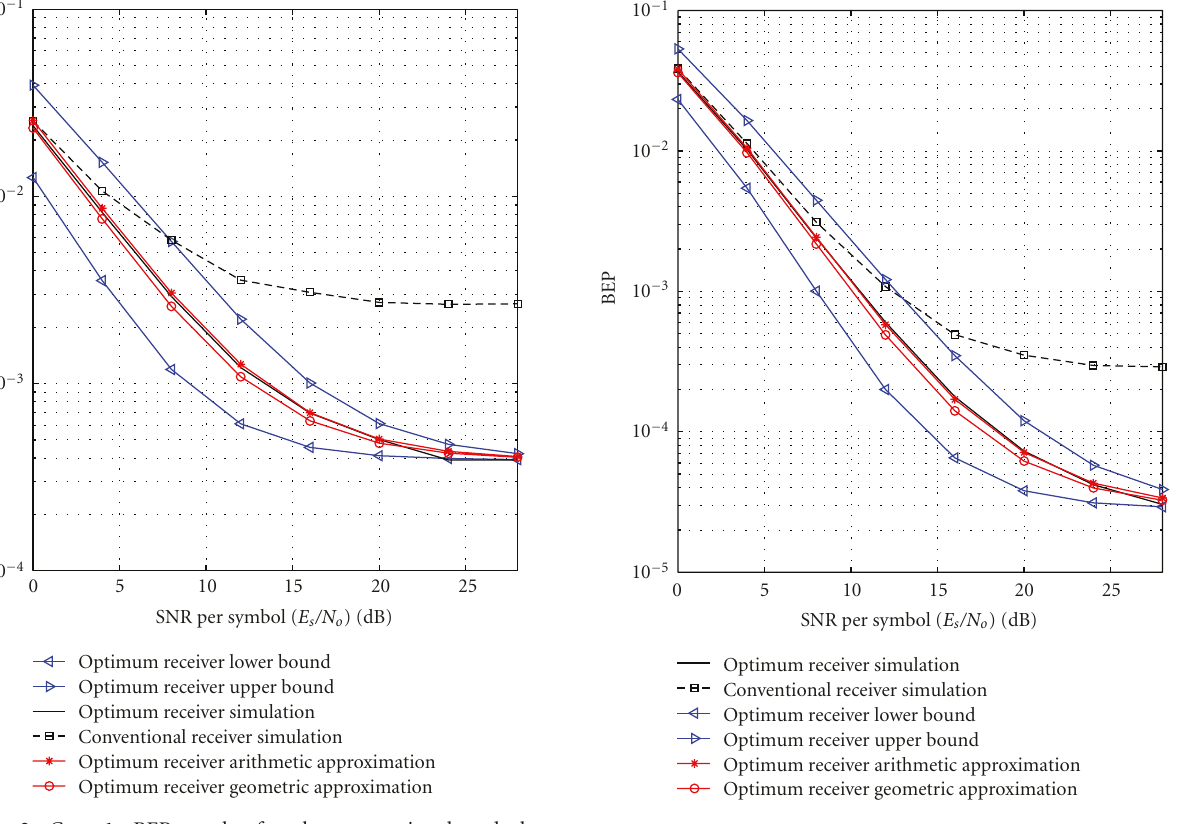
Figure 3: Case 1: BEP results for the conventional and the optimum SBS receivers, 2Tx and 2Rx Alamouti’s code with QPSK modulation, f d T b = 0 . 06, channel variances are 0.5 and 5,